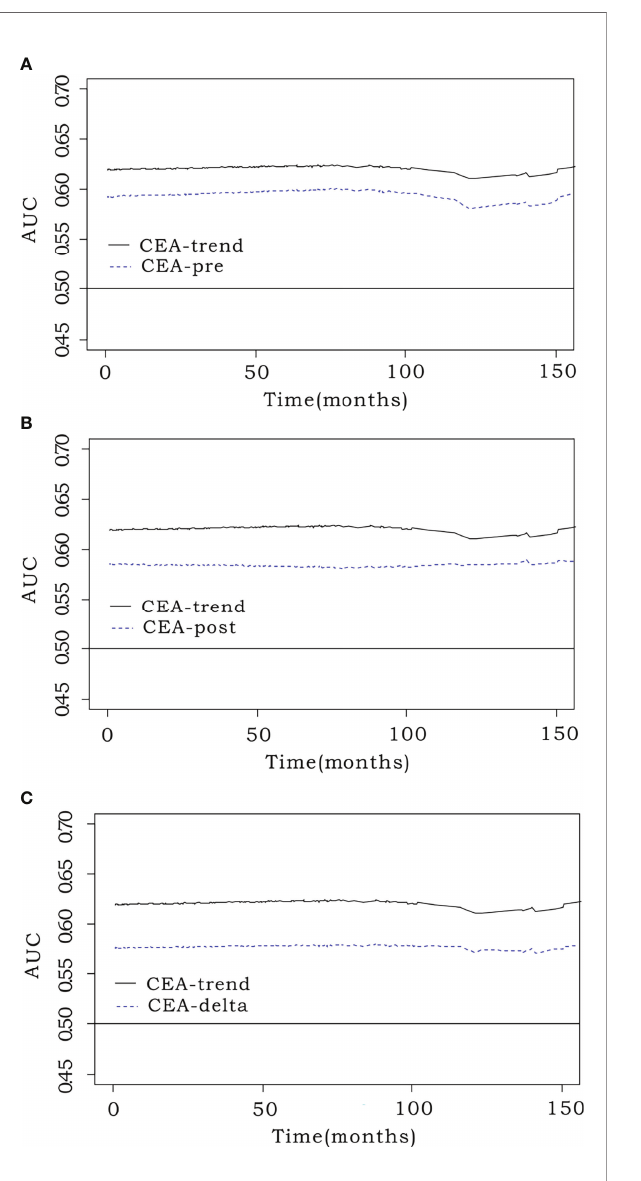
FIGURE 2 | Comparison of predictive performance using the integrated area under the curve (iAUC). Prognostic ef fi cacy was measured using the iAUC (weighted mean of AUCs over the follow-up period) for each model. The time- dependent receiver operating characteristic curve of CEA-trend (0.62; 95% con fi dence interval [CI], 0.571 – 0.675) had an elevated position over that of (A) preoperative CEA (CEA-pre) (0.583; 95% CI, 0.513 – 0.636) (bootstrap iAUC mean difference=0.037; 95% CI, 0.009 – 0.116), (B) early postoperative CEA (CEA-post) (0.591; 95% CI, 0.541 – 0.655) (bootstrap iAUC mean difference=0.029; 95% CI, 0.012 – 0.052), and (C) CEA level change (CEA- delta) (0.568; 95% CI, 0.504 – 0.616) (bootstrap iAUC mean difference=0.052; 95% CI, 0.017 – 0.116).